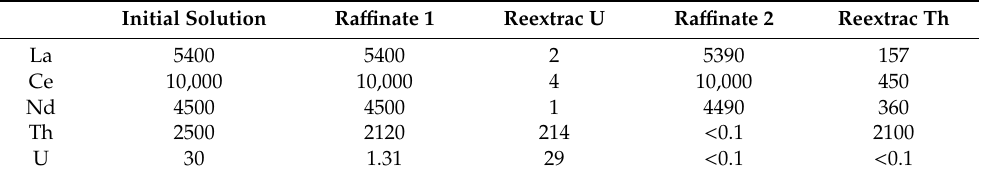
Table 5. The content of REEs, uranium and thorium at various stages of the technological scheme (in mg / L) in the first